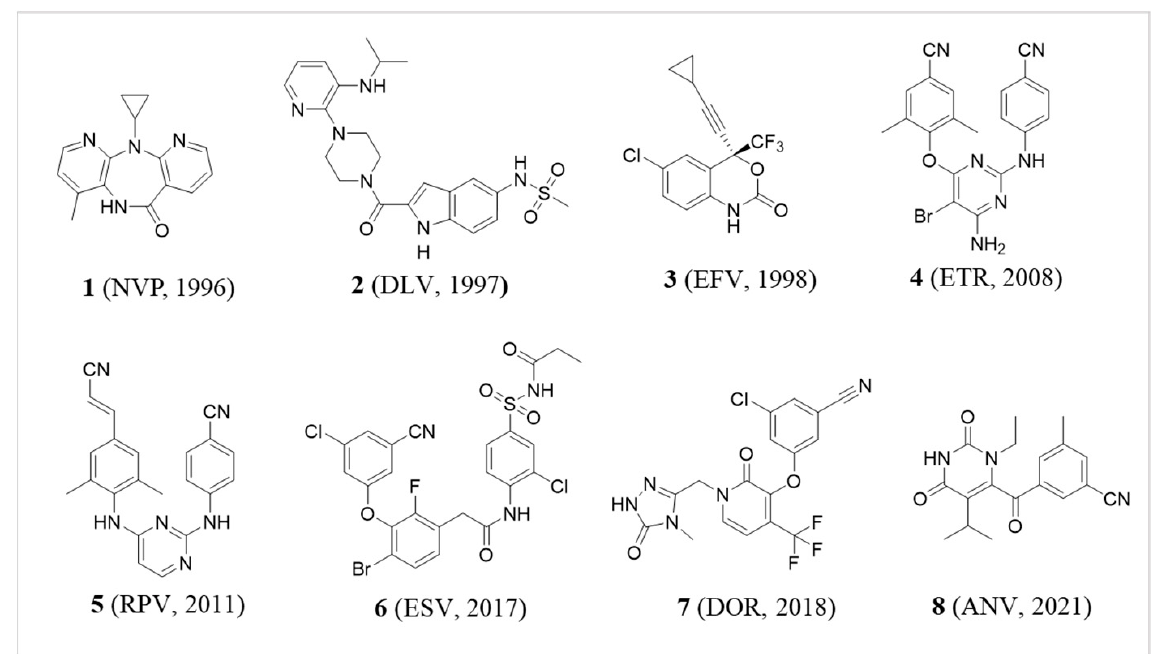
Figure 1. US FDA, Russian MoH and NMPA-approved NNRTI chemical structures.